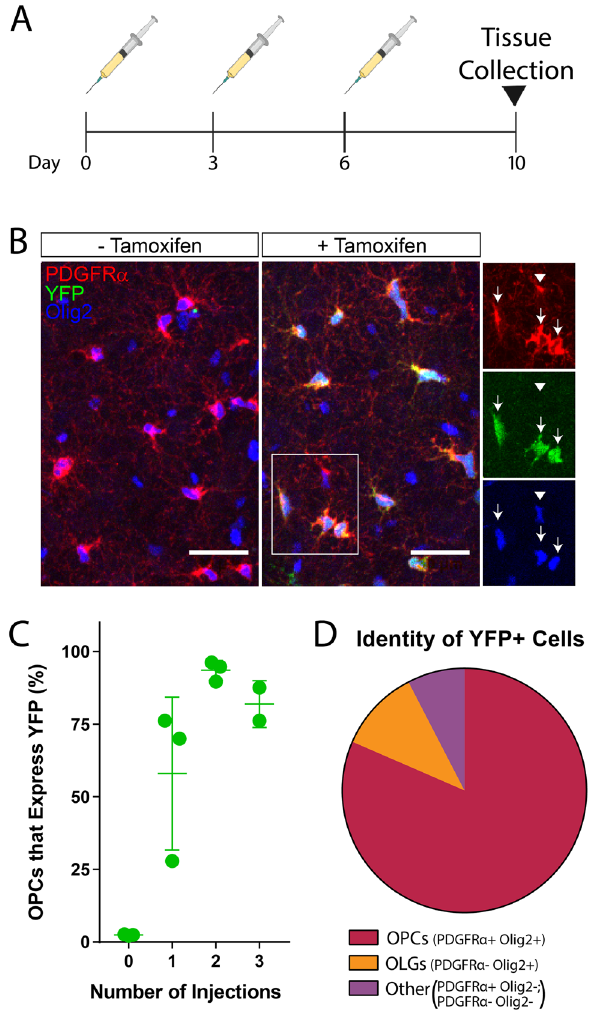
Figure 1. Validation of PDGFRα-Cre ER ; R26-EYFP reporter mouse. ( A ) Timeline of tamoxifen injections and tissue harvest used to validate YFP expression and titrate optimal tamoxifen dosing paradigm. ( B ) Immunofluorescence of PDGFRα (red), Olig2 (blue), and YFP (green) in PDGFRα-Cre ER ; R26-eYFP mice receiving no tamoxifen injections (− Tamoxifen) or 2 tamoxifen injections (+ Tamoxifen). Arrows represent OPCs expressing YFP and arrowheads represent OPCs lacking YFP expression. Scale bar = 30 µm. ( C ) Percentage of OPCs (PDGFRα+/Olig2+) that also express YFP following 0, 1, 2, or 3 tamoxifen injections. N = 3 independent experiments, n = 2–3 per group. Error bars represent SEM. ( D ) Proportion of YFP+ cells identified as OPCs (PDGFRα+/Olig2+), Oligodendrocytes (OLG, PDGFRα−/Olig2+), or neither of these cell types (Other, PDGFRα+/Olig2− or PDGFRα−/Olig2−) following 2 tamoxifen injections. N = 2 independent experiments, n = 3 samples. Data quantified in ( C,D ) include images from the prefrontal cortex, hippocampus, and corpus